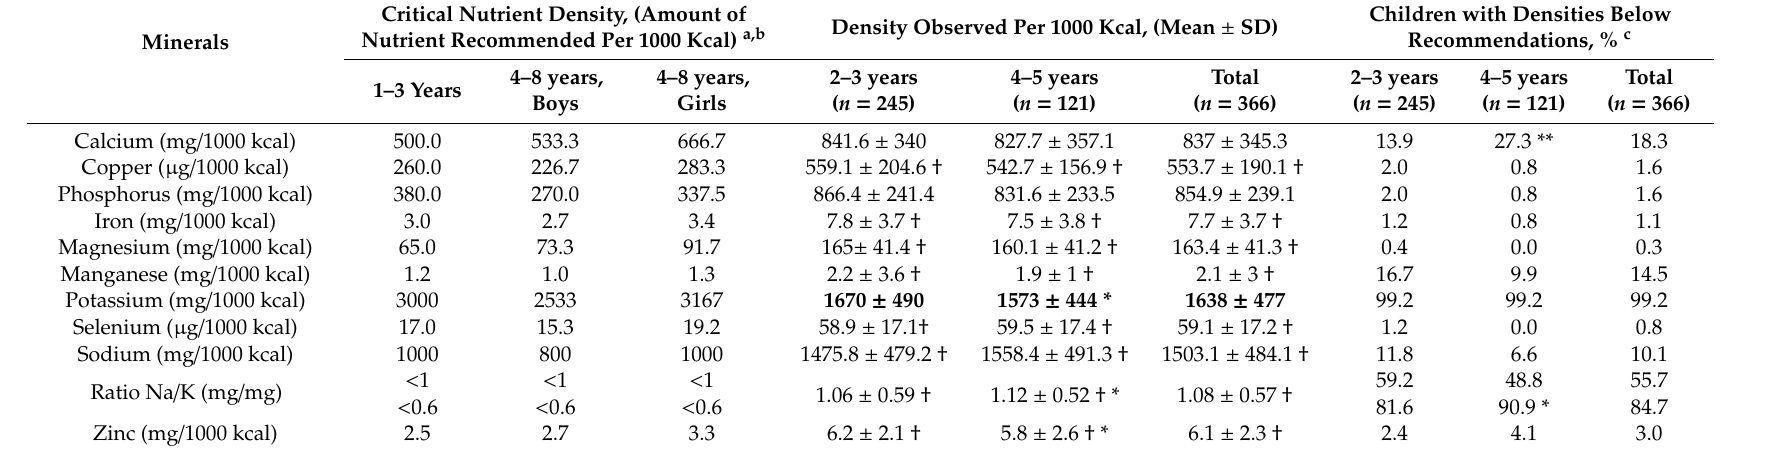
Table 3. Mean mineral density per 1000 kcal and adequacy of mineral intake by age